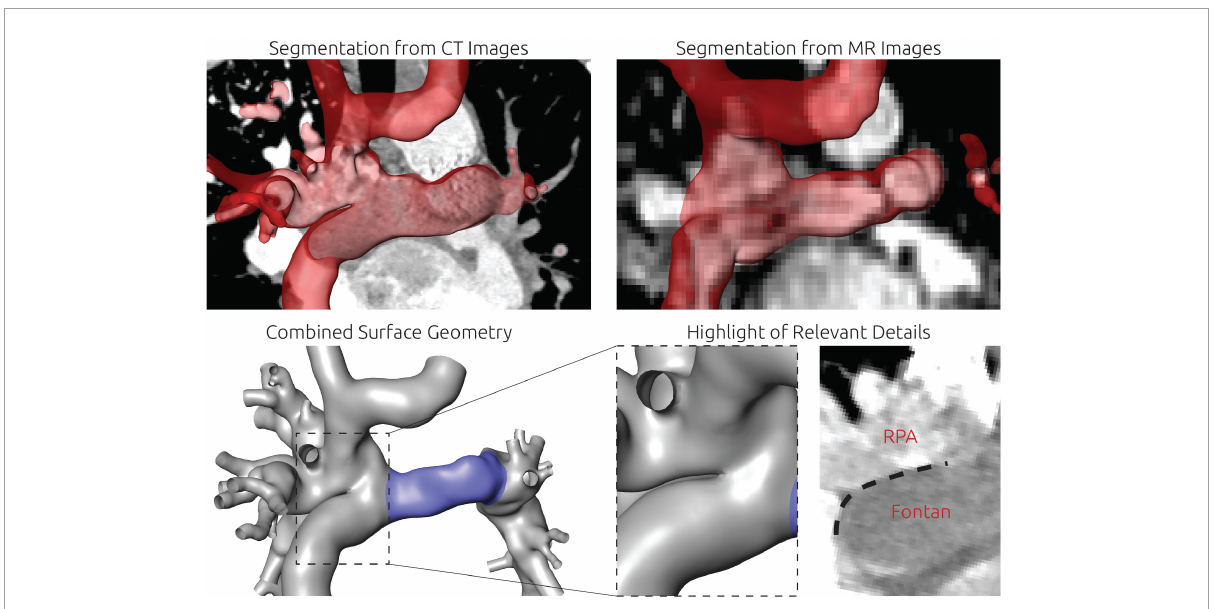
FIGURE4 Detailed overview of the segmentation strategy for the first patient. The upper left and right panel show the segmentation from CT and CMR images, respectively. The lower left panel shows the final surface geometry that was reconstructed by combination of both segmentations. Tissue highlighted in blue was reconstructed from CMR images, whereas the remaining tissue was reconstructed from CT images. The lower right panel highlights the complex connection between RPA, SVC, and Fontan conduit, which could only be discriminated in CT images due to the distinct Hounsfield gradient from Fontan conduit to